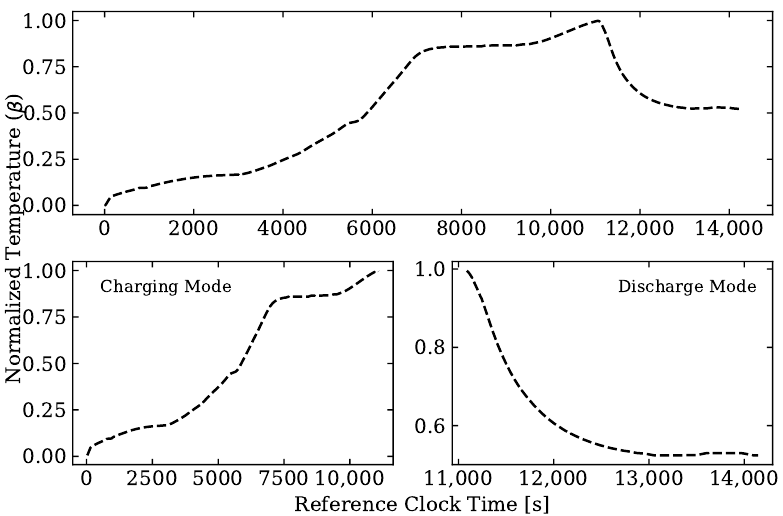
Figure 17. Normalized temperature data from the thermocline outlet location: reference value, T o = 414 ◦